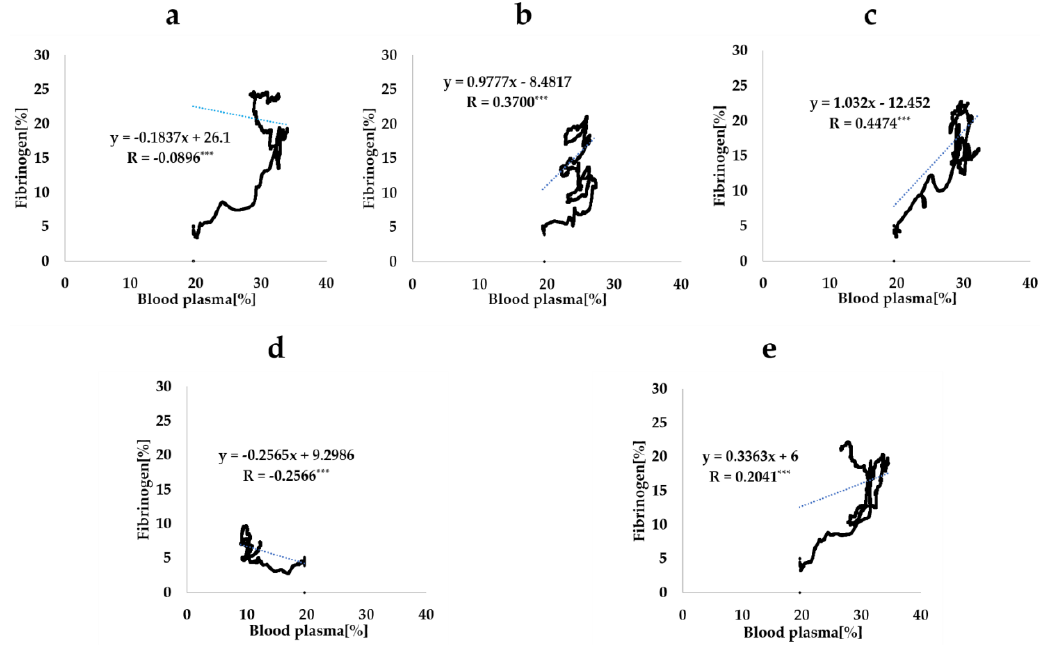
Figure 8. Scatter plots of the fibrinogen infiltration rate and blood plasma infiltration rate. The CAIS values are 0° ( a ), 30° ( b ), 50° ( c ), 70° ( d ), and 100° ( e ). Each dotted line is the regression line calculated from each scatter plot. R indicates the correlation rate (*** p < 0.001).